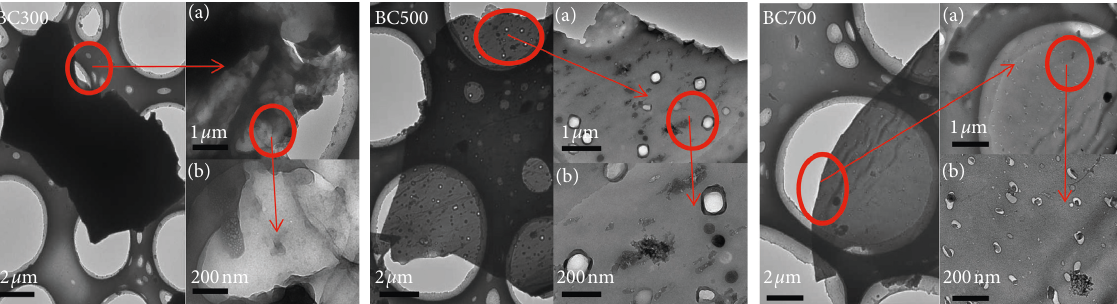
Figure 2: Transmission electron microscopy (TEM) images of BC300, BC500, and BC700 at different dimensions. Table 3: Selected physicochemical properties of BC300, BC500, and BC700.